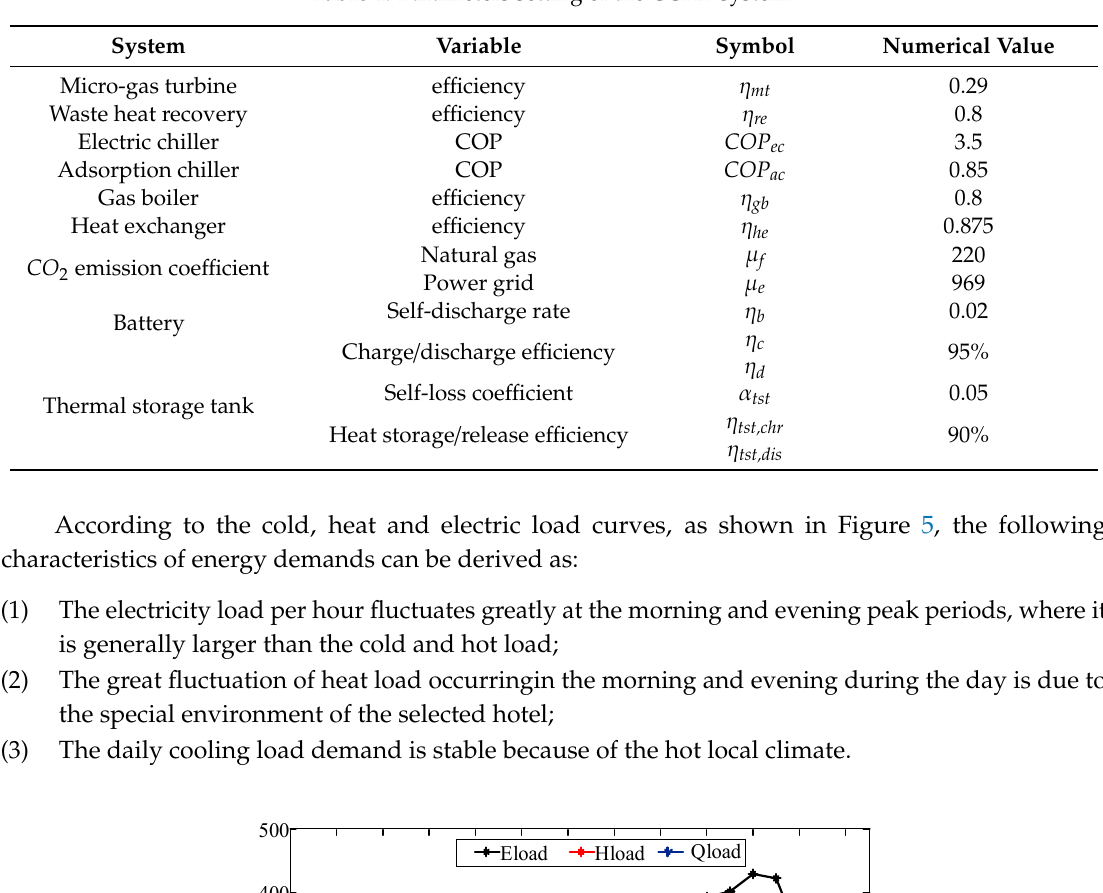
Table 4. Parameters setting of the CCHP system.